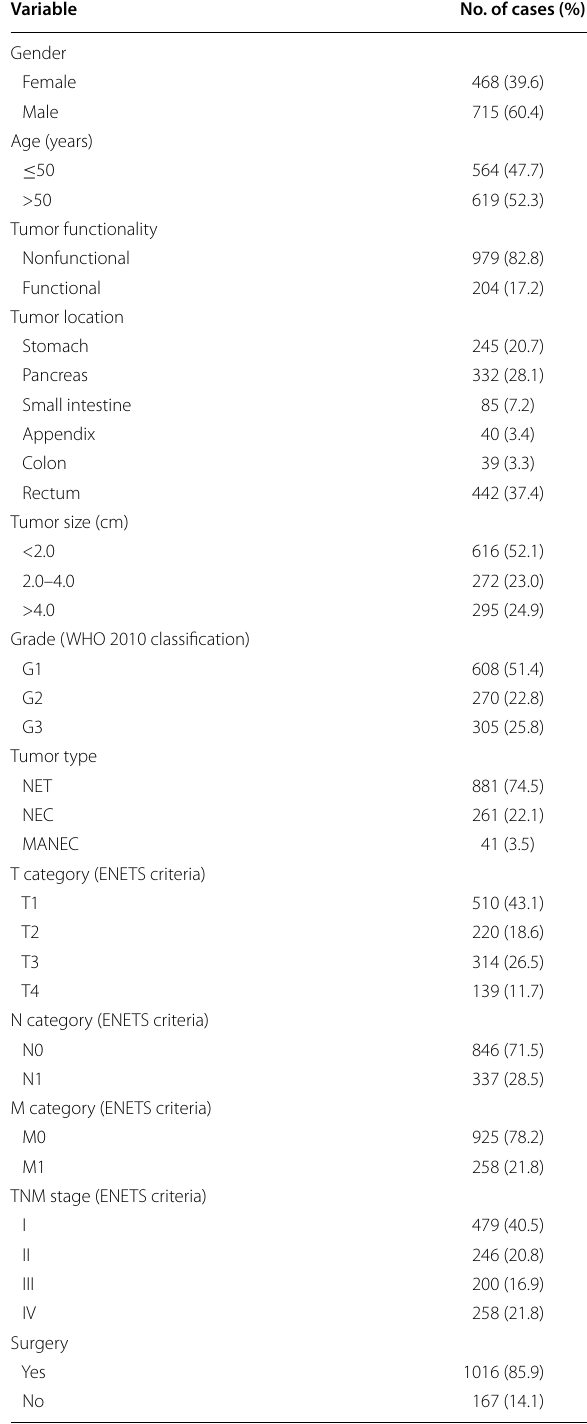
Table 1 Clinicopathologic characteristics of 1183 patients with gastroenteropancreatic neuroendocrine